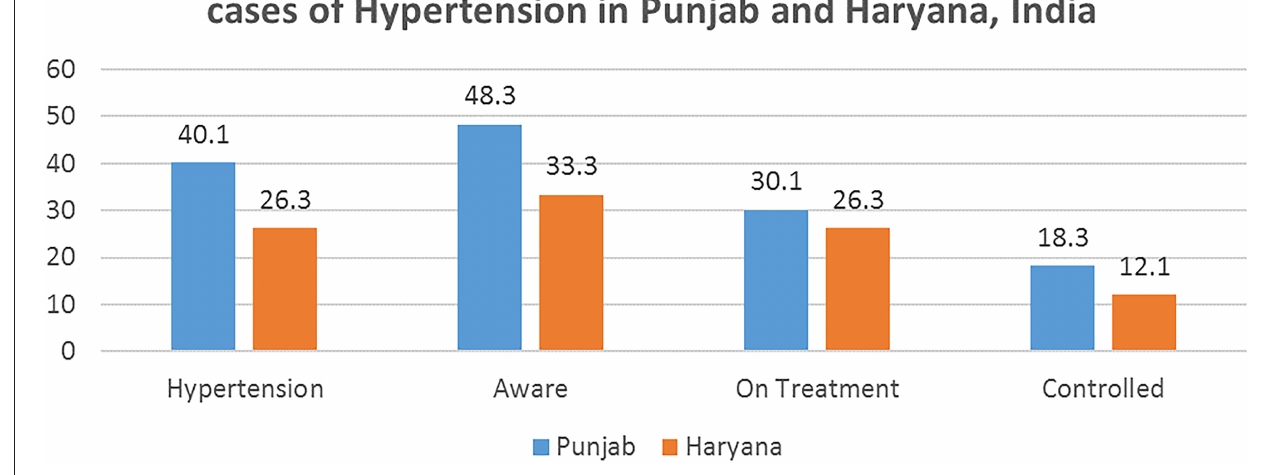
Frontiers in Public Health |